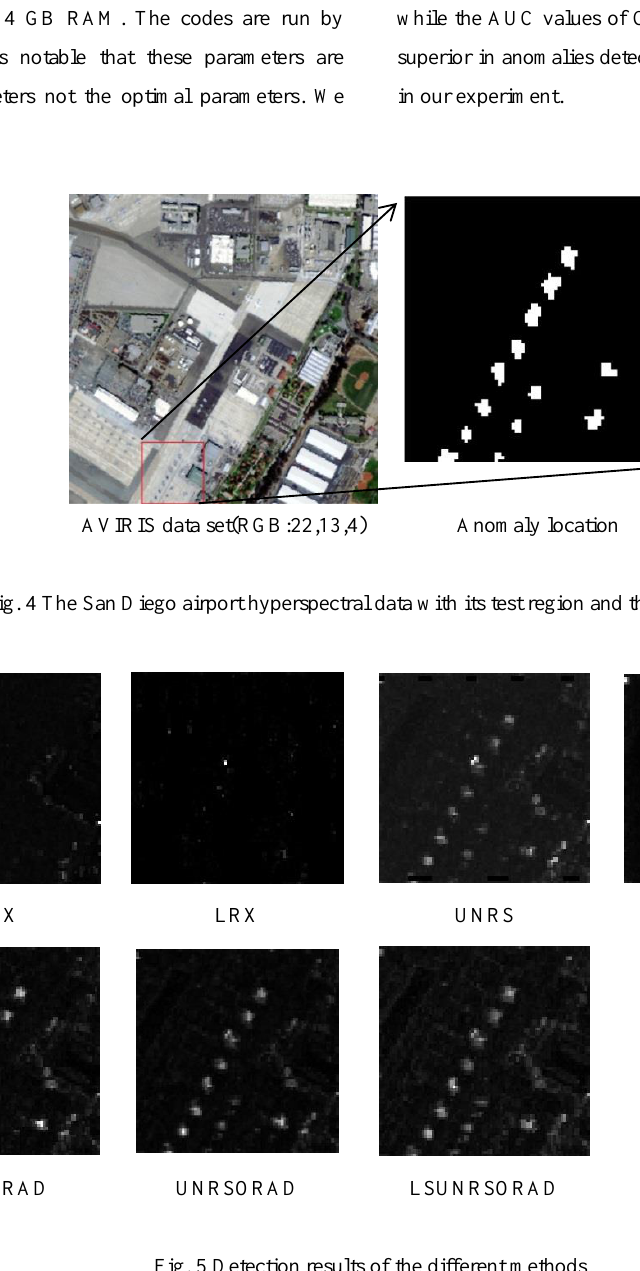
Fig. 5 Detection results of the different